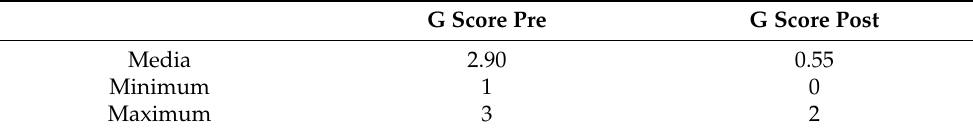
Table 3. Comparison of G scores pre and post-modified Montgomery thyroplasty.